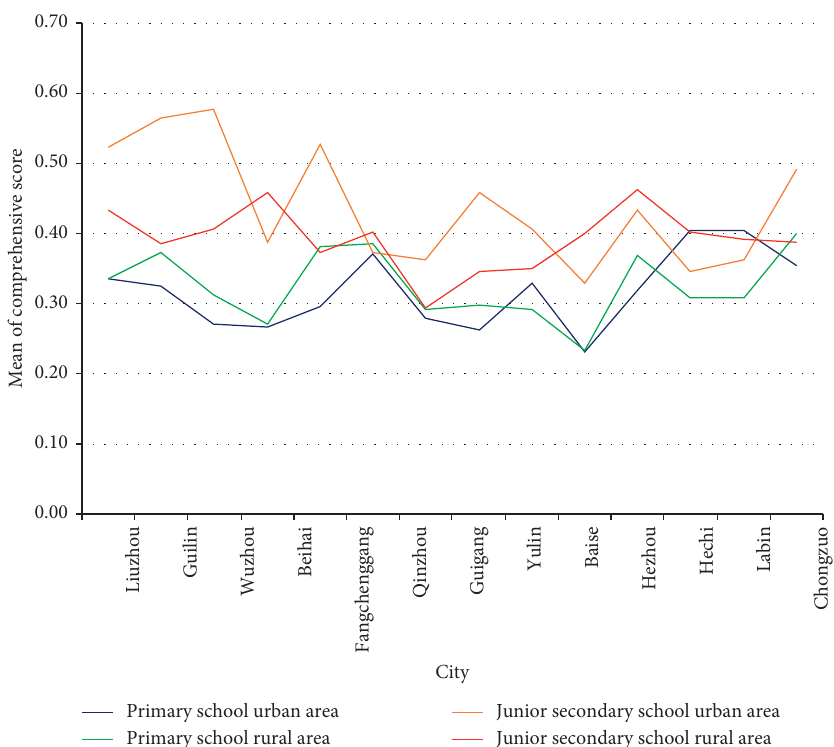
Figure 2: For primary school, the highest urban area score is in Labin (0.405) and rural area is in Chongzuo (0.399), with a difference of 0.006. The lowest urban area score was in Baise (0.232) and the rural area was in Baise (0.310) too, with a difference of 0.078. For junior secondary school, the max urban area score is in Guilin (0.577) and the rural area is in Hezhou (0.463), with a difference of 0.114. The min urban area score is in Hezhou (0.233) and the rural area score is in Qinzhou (0.294), with a difference of 0.061. The trend of the graph and the difference between urban and rural areas show that there is no significant difference in the distribution of educational resources between urban and rural